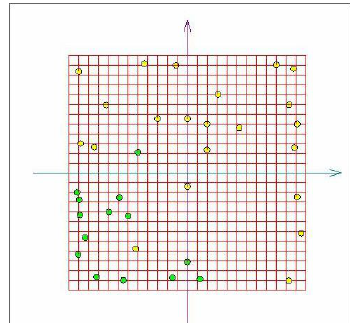
Figure 8. Extension of elastic map for classes con, adi